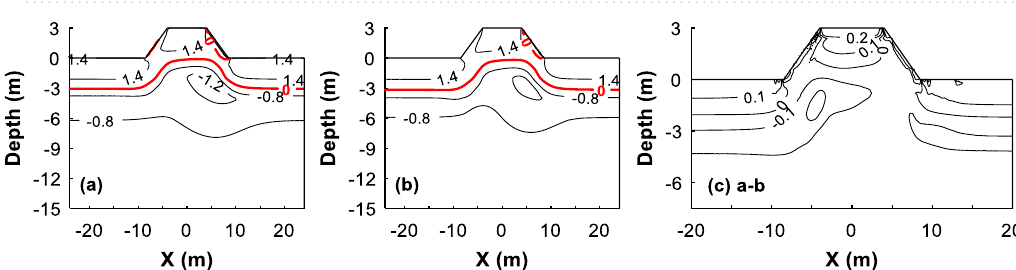
Figure 6. Comparison between the HFM-predicted temperatures and TCM-predicted ones after the embankment is constructed for 5 years. Date: On October 19. ( a ) HFM-predicted temperature, ( b ) TCM- predicted temperature, and ( c ) the HFM-predicted temperatures to minus the TCM-predicted